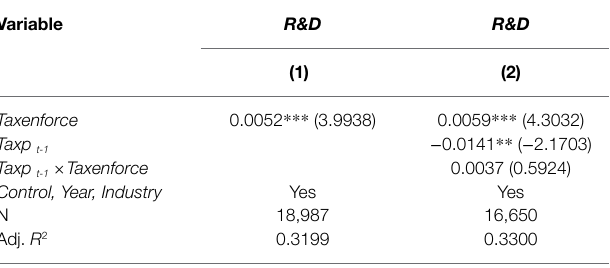
TABLE 4 | Tax enforcement and enterprise R&D investment and its moderating effect. Variable